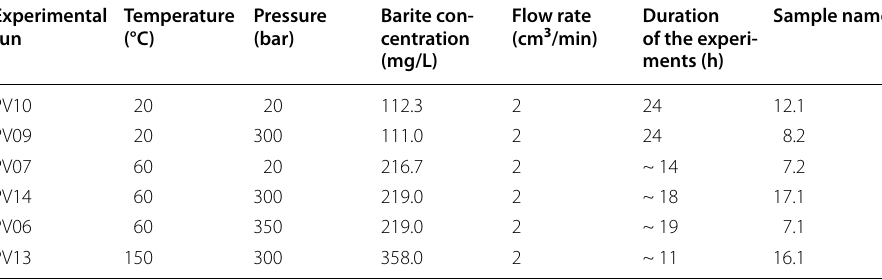
Table 1 Experimental parameters of selected experiments Experimental